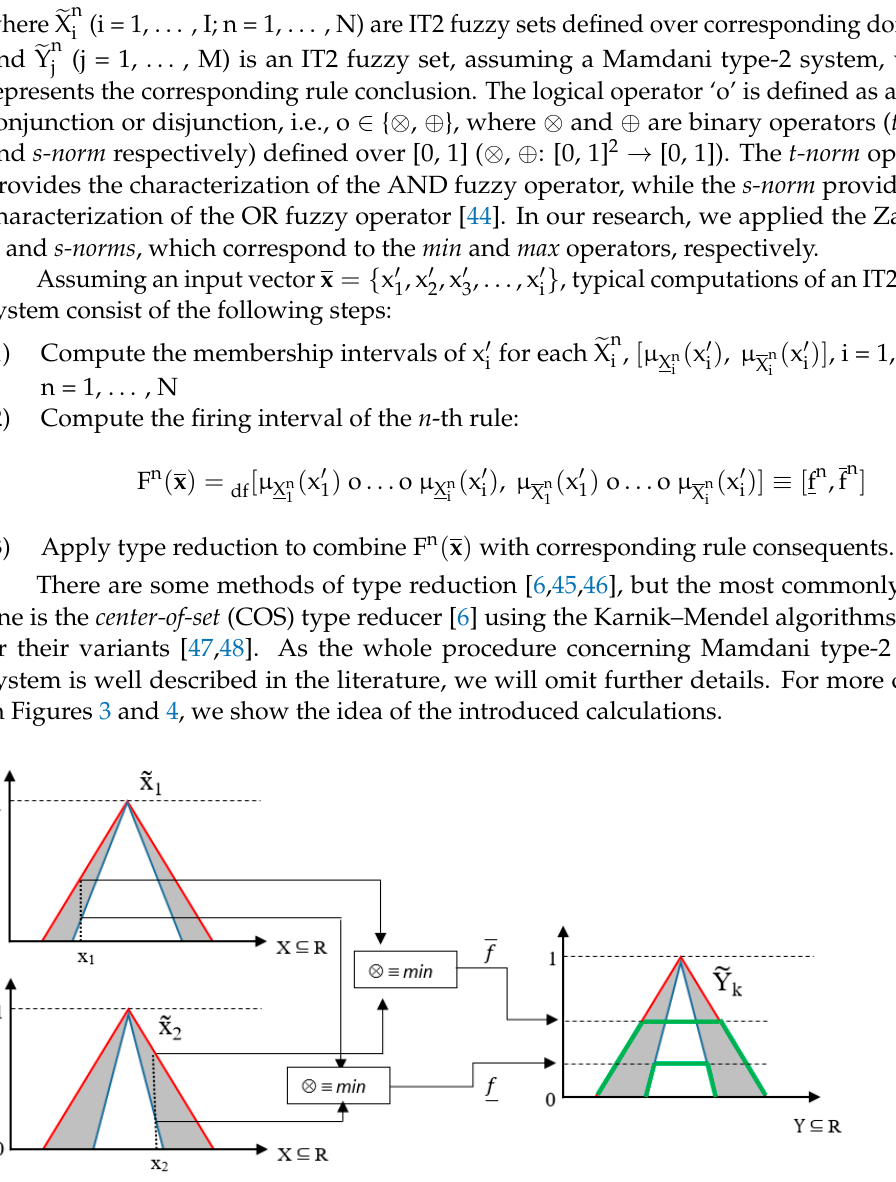
Figure 3. Firing interval calculation along with footprint of uncertainty (FOU) rule output calculation for a sample rule: IF (x is X (cid:3561) 1 ) AND (x is X (cid:3561) 2 ) THEN Y (cid:3561) k .